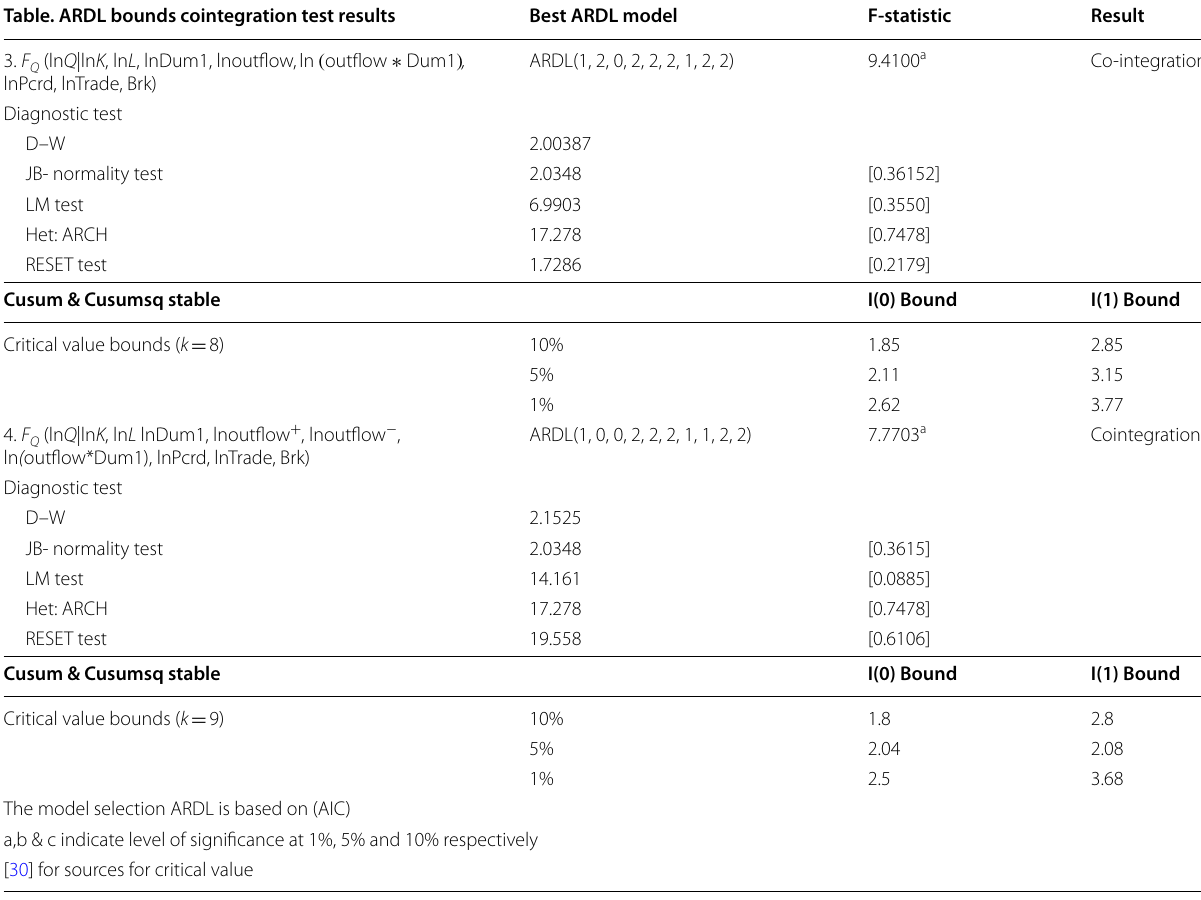
Table 4 FDI-outflow for symmetric and asymmetric ADRL bounds co-integration test Table. ARDL bounds cointegration test